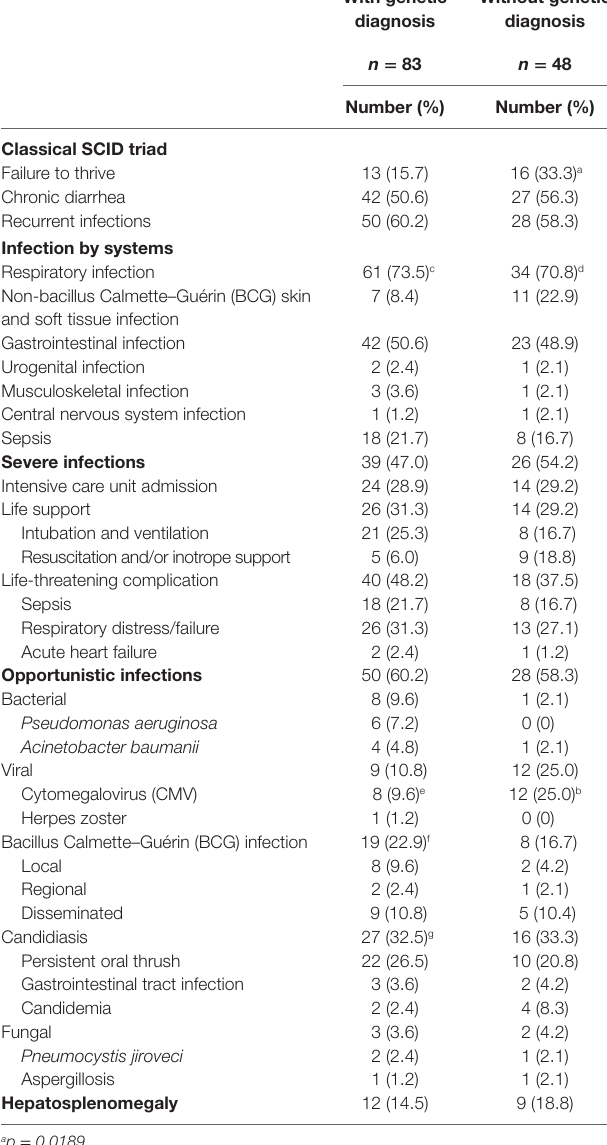
TaBle 4 | Clinical features of patients included in our study ( n = 131). TaBle 5 | Univariate analysis of features that affect age at presentation (AP), age at diagnosis, and time to diagnosis in patients fulfilled selection criteria ( n =